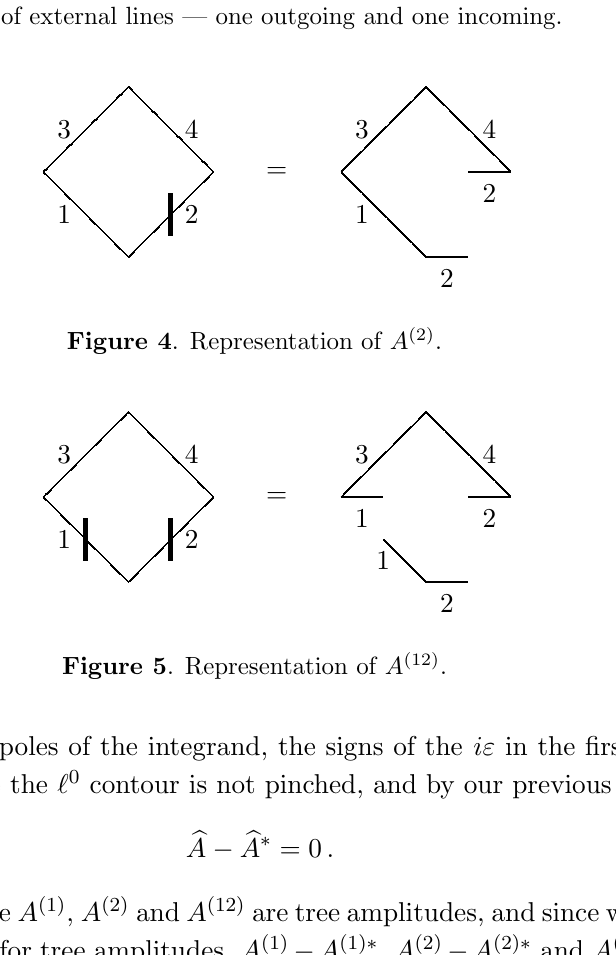
Figure 3 . Representation of A (1) . On the left hand side the vertical line through propagator 1 represents that it is a cut propagator. On the right hand side this is made explicit by replacing the cut propagator by a pair of external lines | one outgoing and one incoming.